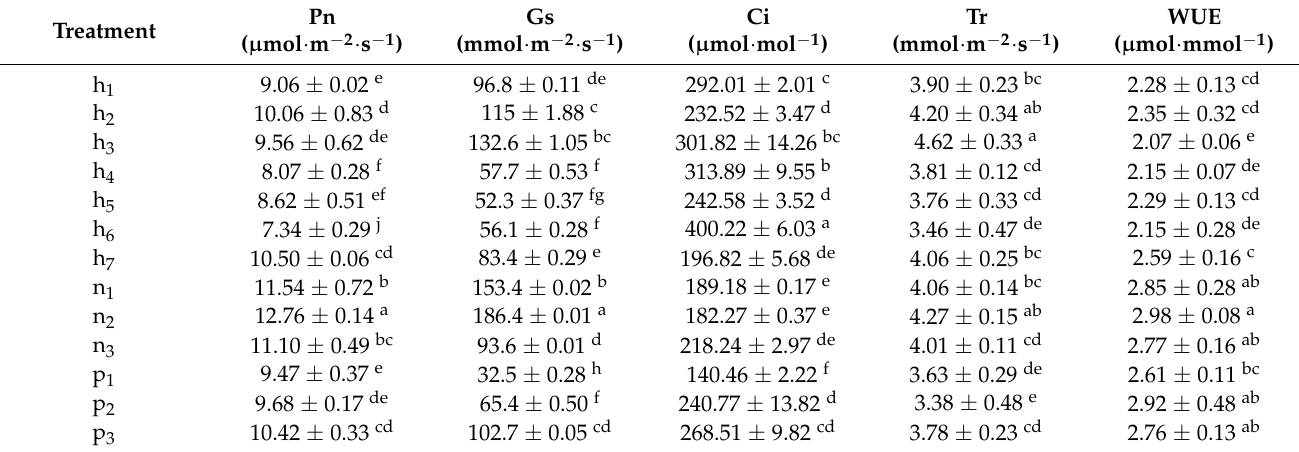
Figure 3. SPAD values of jujube leaves under different fertilization treatments (mean ± SD, n = 30). Mean totals with a common letter are not different ( p < 0.05) by ANOVA for the ranking test. Table 4. Photosynthetic traits of jujube trees under different fertilization treatments (mean ± SD, n = 48). Mean totals with a common letter are not different ( p < 0.05) by ANOVA for the ranking test. Pn = net photosynthetic rate, Gs = stomatal conductance, Ci = intercellular CO 2 concentration, Tr = transpiration rate, and WUE = water use efficiency. Temperature in sample cell is 31.05 ◦ C. Temperature of leaf thermocouple is 30.52 ◦ C. Reference cell CO 2 is 397.86 µ mol CO 2 mol − 1 . Sample cell CO 2 is 392.04 µ mol CO 2 mol − 1 . Relative humidity in the reference cell is 41.67%. Relative humidity in the sample cell is